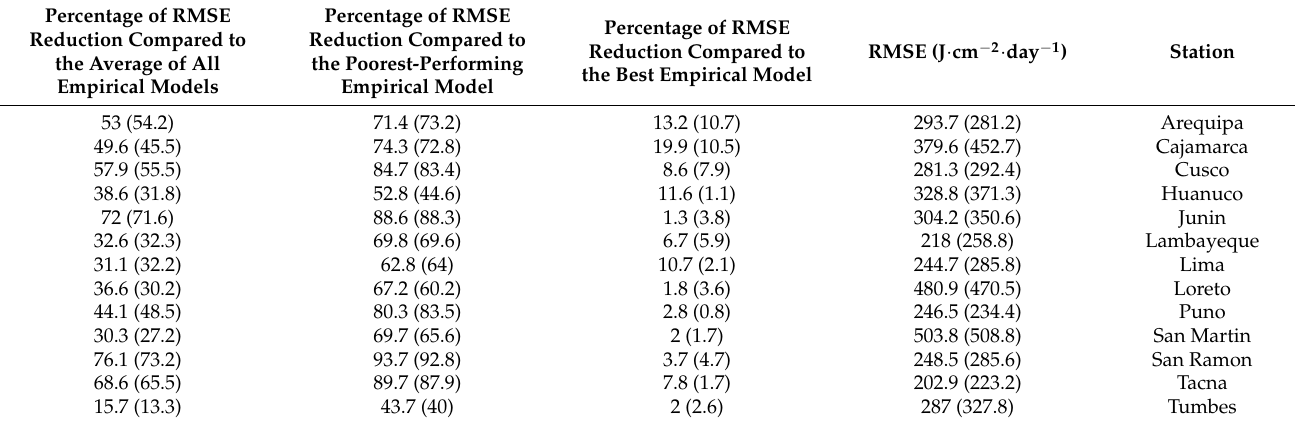
Table 23. RMSEs (J · cm − 2 · day − 1 ) of the proposed models and percentage of RMSE reduction by proposed models compared to best, poorest, and average results of empirical models in each of the 13 selected stations at calibration (validation) set. Percentage of RMSE Percentage of RMSE Reduction Compared Reduction Compared to the Average of All Empirical Models